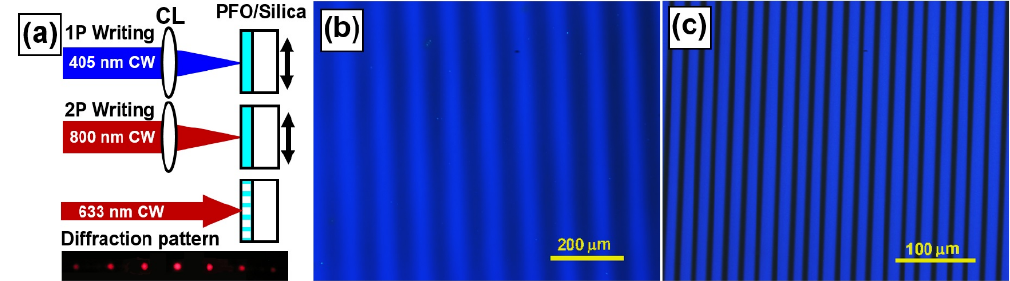
Figure 3. ( a ) Geometry for one ‐ photon (1P) and two ‐ photon (2P) direct writing into a PFB film through focusing a 400 ‐ nm CW and an 800 ‐ nm femtosecond pulsed laser beam by a cylindrical lens (CL), respectively. High ‐ efficiency diffraction by the 2P ‐ written grating is demonstrated by the diffraction pattern of a red laser at 633 nm. Grating structures written by ( b ) one ‐ and ( c ) two ‐ photon processes.